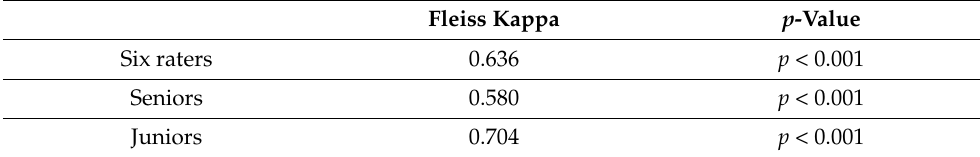
Table 3. Fleiss kappa values between the six raters and between seniors and juniors